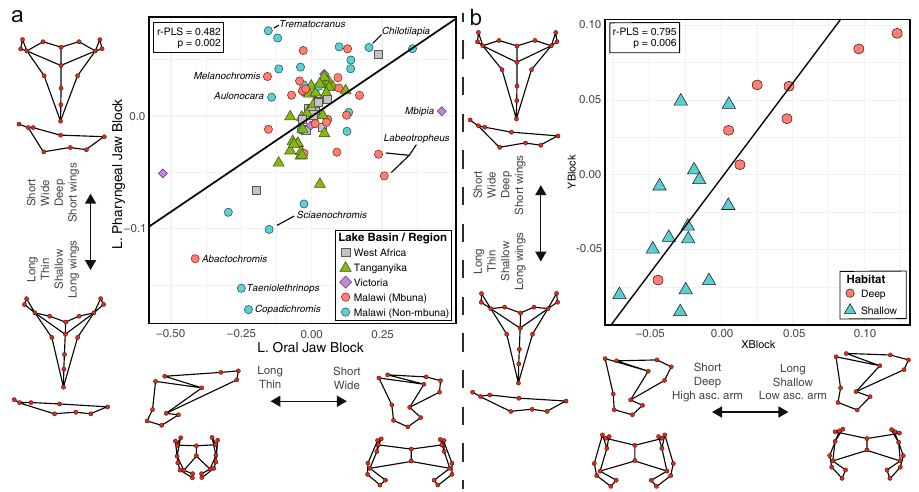
Fig. 2 Phylogenetic two-block partial least squares analysis to assess macroevolutionary associations between lower oral and pharyngeal jaws. a Jaw shape associations across a broad sample of African cichlids ( n = 88). Taxa from Lake Malawi are placed into two groups based on phylogenetic position: an mbuna ‘ rock-dwellers ’ group, and a non-mbuna group consisting of the utaka ‘ sand-dwellers ’ alongside other benthic species 88 . b Jaw shape associations across the Tropheops sp . species complex from across a depth gradient ( n = 22). Oral and pharyngeal jaw wireframes denote morphologies at either end of the correlational axis. Source data are provided as a Source Data fi